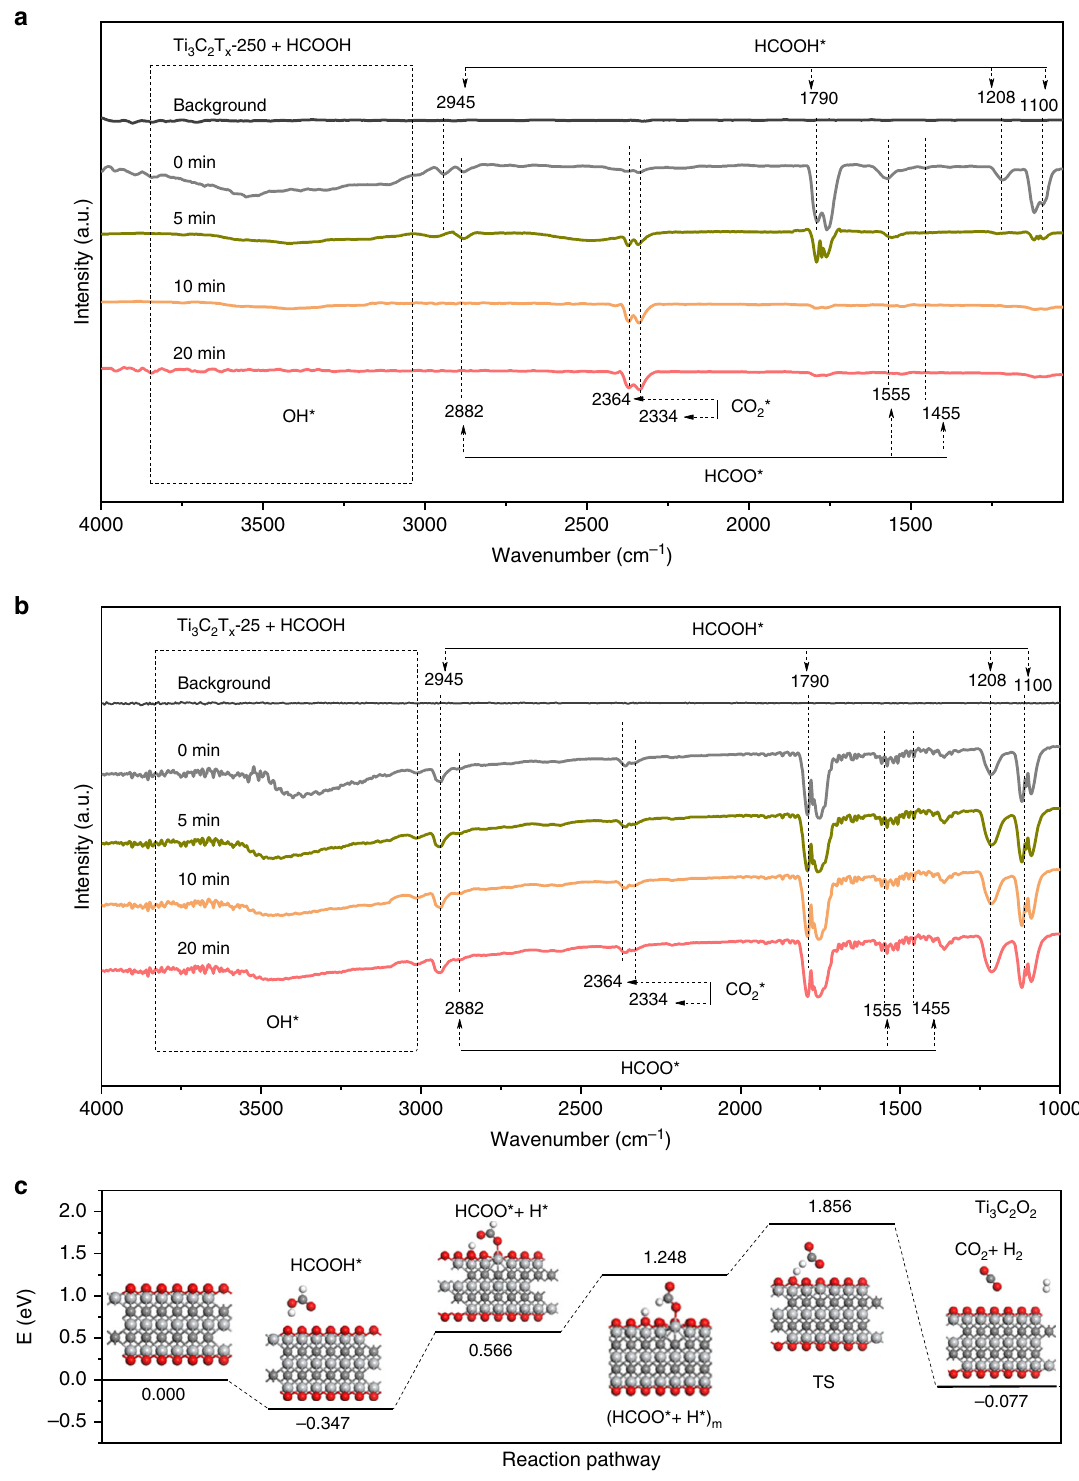
Fig. 5 Investigation of the reaction mechanism for HCOOH dehydrogenation. a , b In situ DRIFT spectra for Ti 3 C 2 T x -250 and Ti 3 C 2 T x -25 after the treatment of HCOOH. c Reaction paths for the dehydrogenation of HCOOH over Ti 3 C 2 O 2 . Asterisk (*) and subscript m represent the adsorbed species and meta-stable state, H 2 from two surface H atoms bonded to the surface of Ti 3 C 2 O 2 . surface oxygen atoms, consistent with the results of in situ The result indicated that this process was highly impeded DRIFT. Moreover, the energy barrier was lowered with the thermodynamically with a reaction energy of 1.10 eV. Based on increasing of coverages of surface oxygen atoms. In addition, the above analysis, HCOO * was the intermediate in HCOOH the oxygen atoms on the surface of Ti 3 C 2 O 2 also bene fi ted to the desorption of CO 2 and H 2 with the adsorption energies of − 0.16 dehydrogenation over all three models with different coverages of